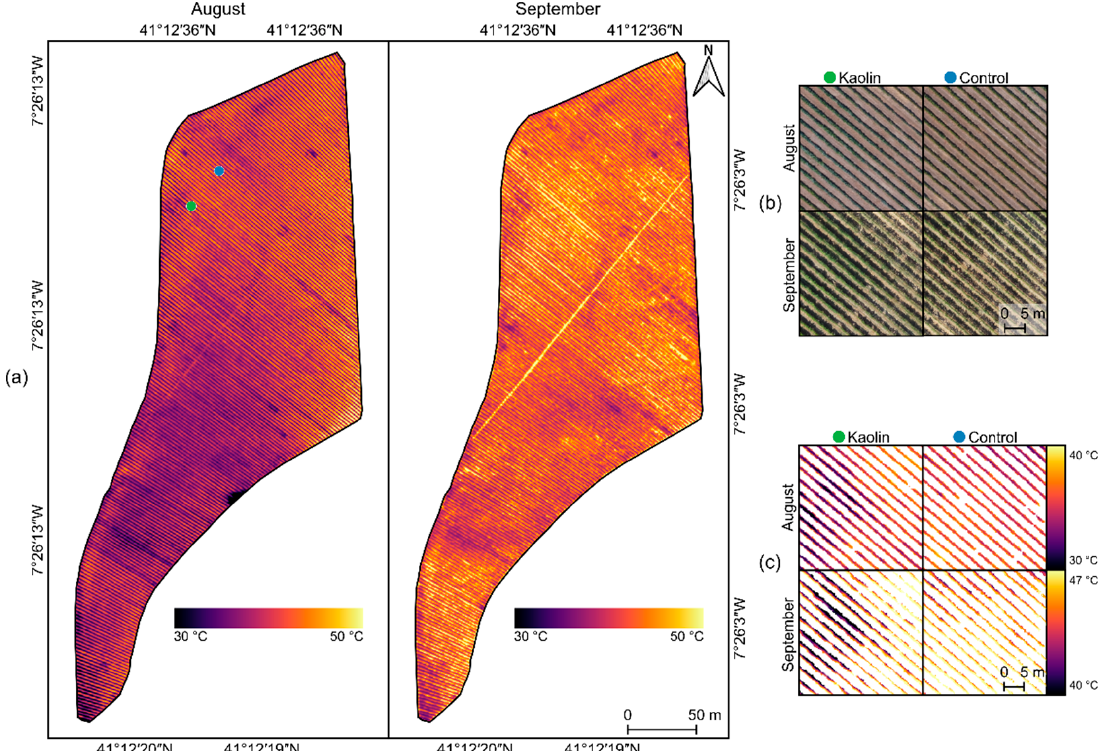
Figure 4. Land surface temperature of the thermal infrared data acquired from an unmanned aerial vehicle for the August and the September flight campaigns ( a ). Close ‐ up view of the points high ‐ lighted in ( a ) of the RGB orthophoto mosaic ( b ) and thermal infrared imagery filtered for grapevine vegetation ( c ) in kaolin and control areas in August and September flight campaigns.